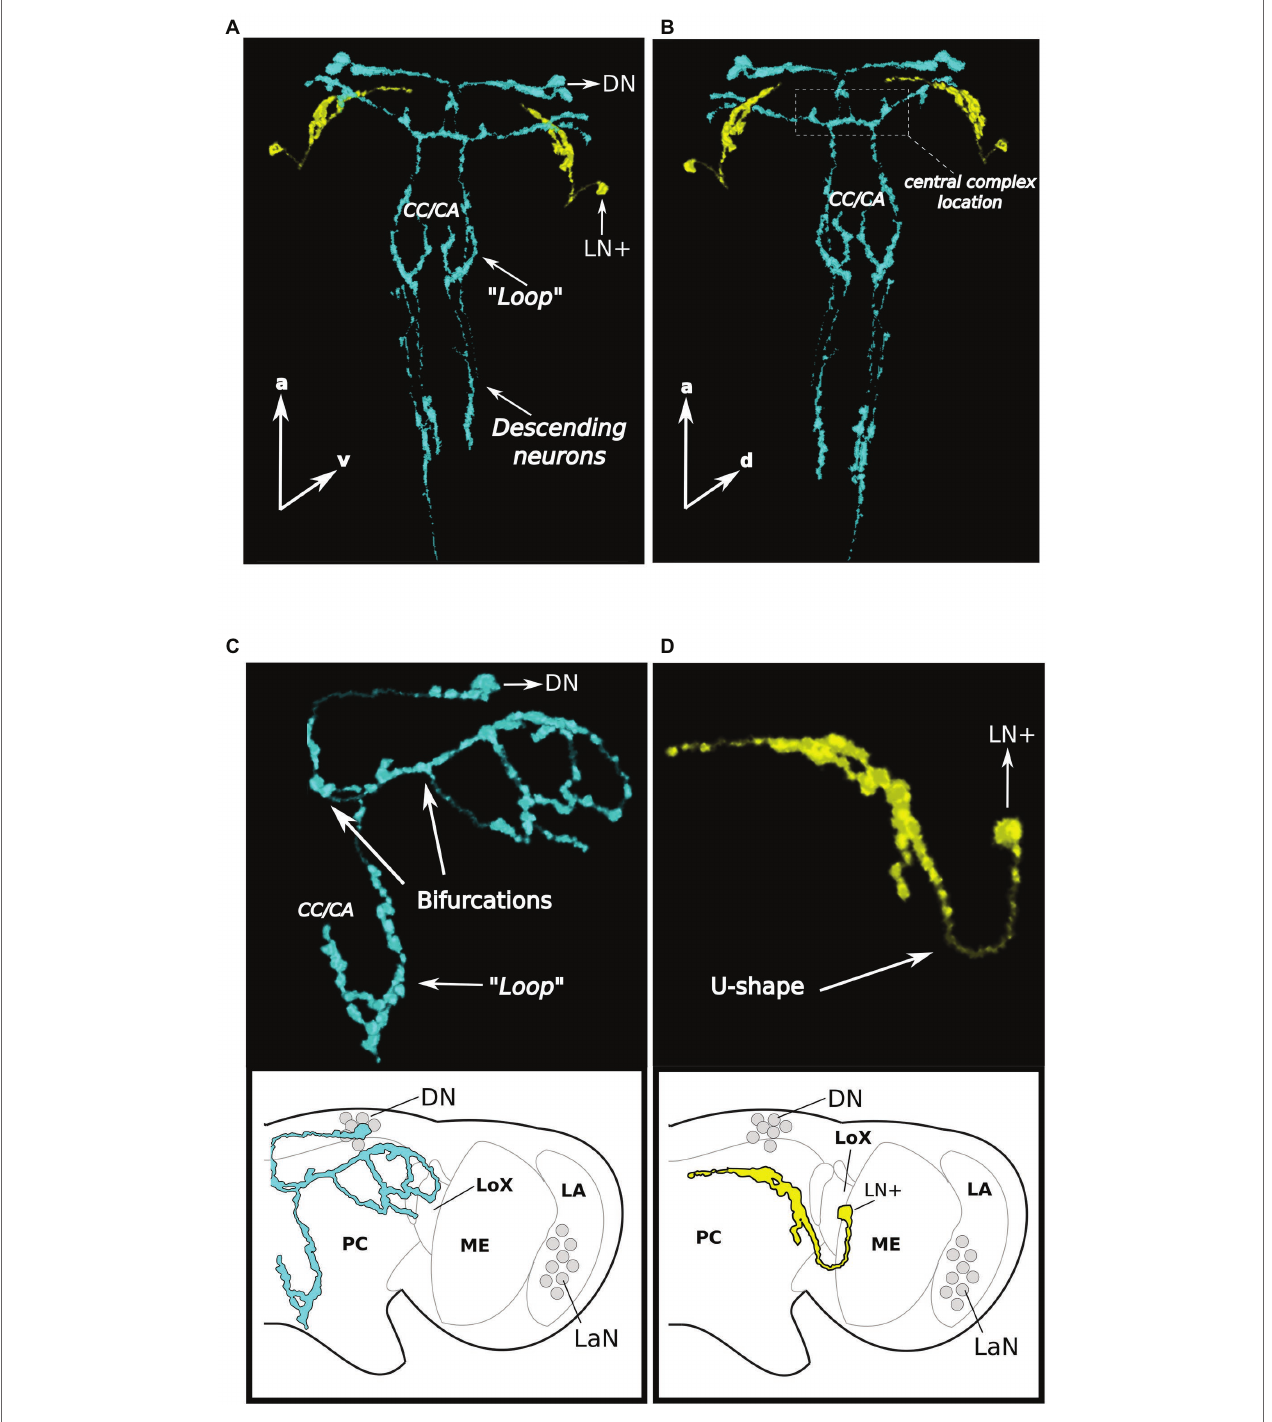
FIGURE 8 | CRY neurons arborize widely in the aphid protocerebrum and descend to the thoracic ganglia. Two brains are reported as examples in (A) and (B) , first example, the arborizations are shown in a dorsal and ventral view, respectively, and the posteriorly descending neurons are visible in (C) and (D) , second example, only the DN arborizations (without descending neurons) and the LN+ arborizations are shown, respectively. (A–C) . The 3D reconstruction of the CRY positive DNs (light-blue) shows that they project toward the pars intercerebralis, turn toward the central complex and then bifurcate twice. Some fibers run laterally while others run posteriorly, form a “Loop” in the region corresponding to the corpora cardiaca/allata complex and then descend further. (A,B,D). The fiber starting from the LN+ neuron (in yellow) makes a U-shape-turn and projects anteriorly. CC/CA, Corpora cardiaca/corpora allata; PC, Protocerebrum; ME, Medulla; LA, Lamina; LoX, Lobula complex; and LaN, Lamina